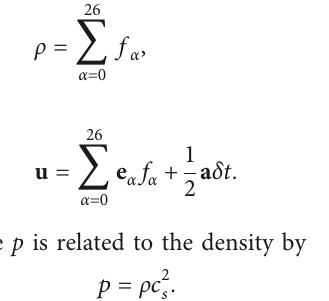
Figure 2: Mass tracking algorithm